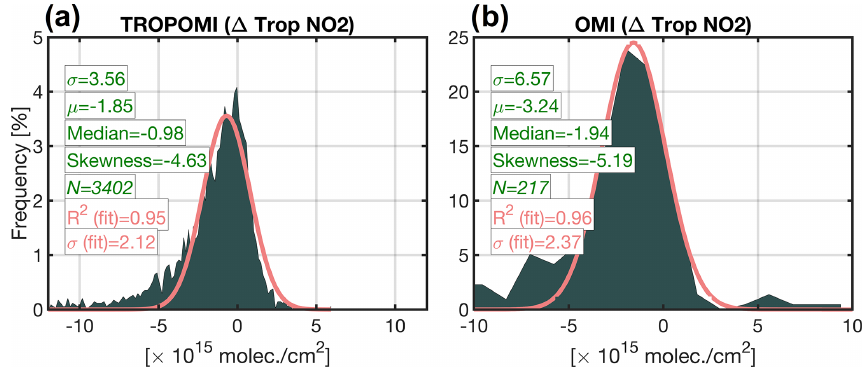
Figure 10. The histogram of the differences between TROPOMI and OMI and benchmarks. MAX-DOAS and integrated aircraft spirals are the TROPOMI and OMI benchmarks, respectively. The data curation and relevant criteria on how they have been paired can be found in Verholest et al. (2021) and Choi et al. (2020). The statistics in green are based on all data, whereas those in pink are based on the fitted Gaussian